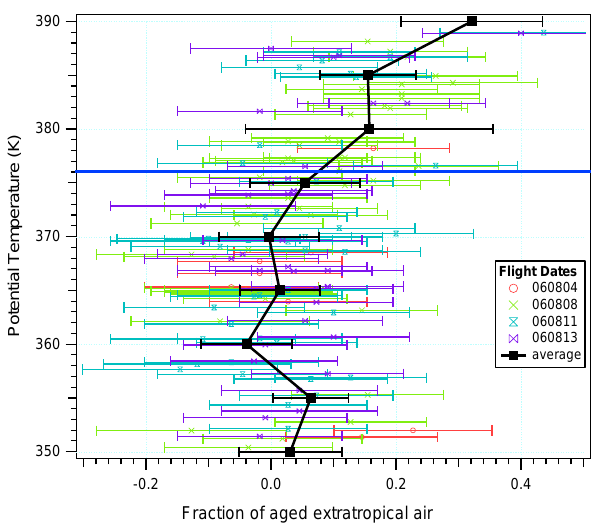
Fig. 8. Fraction of aged extratropical air. The blue line represents the average height of the tropopause.